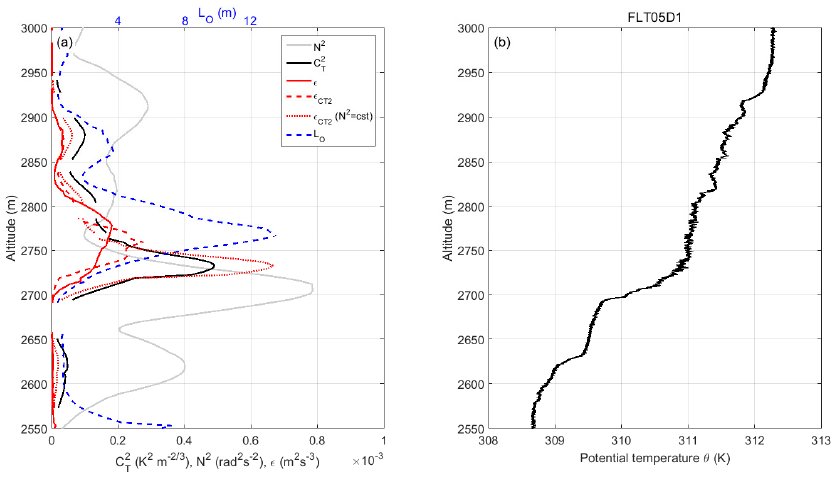
Figure 19. ( a ) Expanded view of Figure 15, including ε and ε CT 2 with measured and constant N 2 and L O . ( b ) The corresponding potential temperature profile